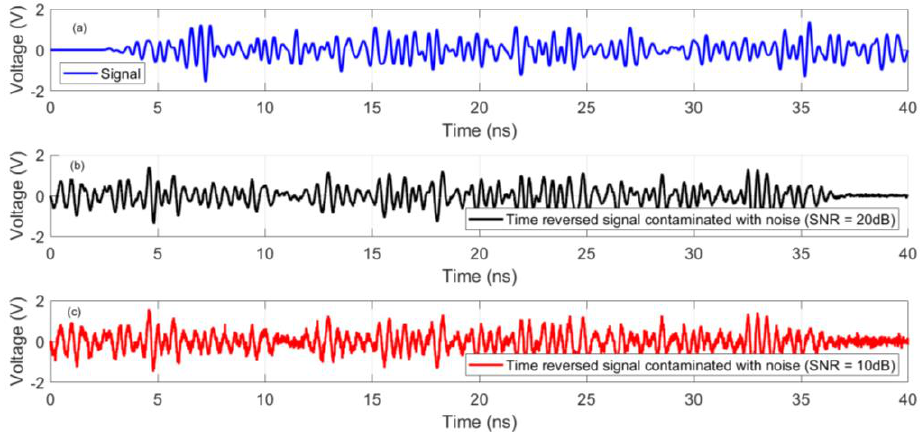
Figure 7. Normalized distribution of the maximum electric field power over the complete simulation time inside the transformer tank in the x-z cut plane (CS #5). The active parts of the transformer are included. The ground truth locations of the PD sources (PD1 and PD2) are shown by “+” markers. Only one sensor (S1) is used.